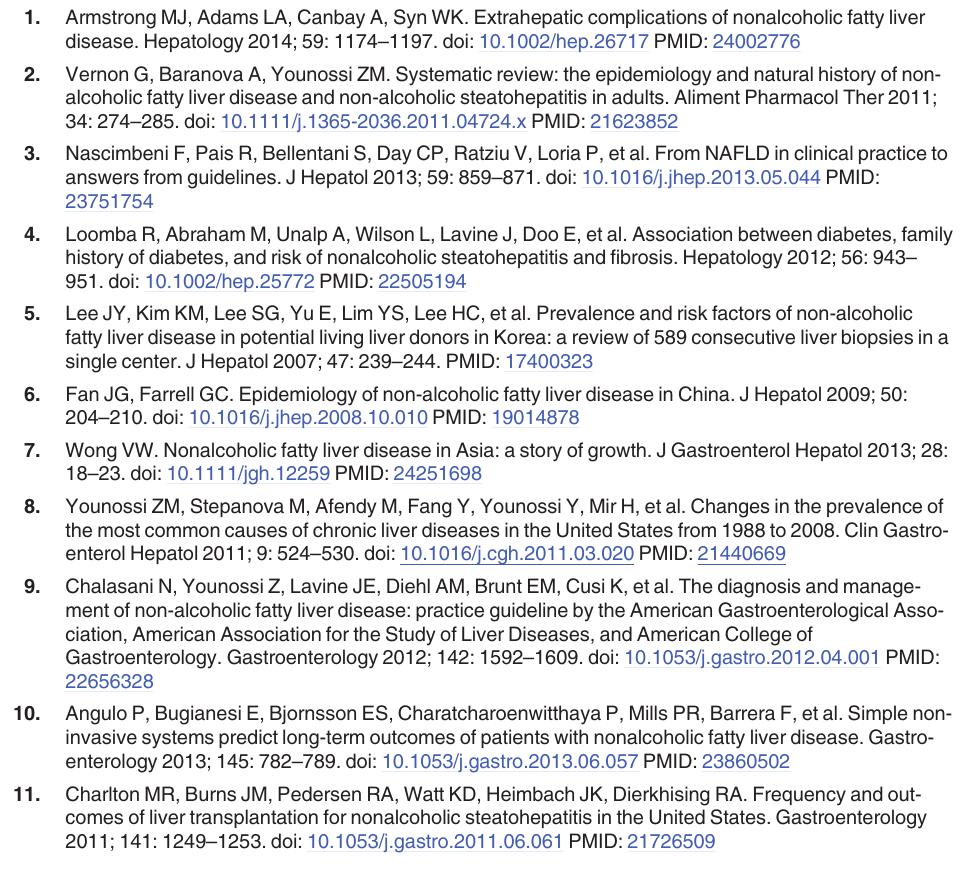
S1 Table. Comparison of demographic characteristics between male and female subjects. S2 Table. Comparison of prevalence rates of ultrasonogrphic fatty liver between male and female subjects stratified by body mass index. S3 Table. Factors associated with ultrasonogrphic fatty liver in different populations by multivariate analysis in model